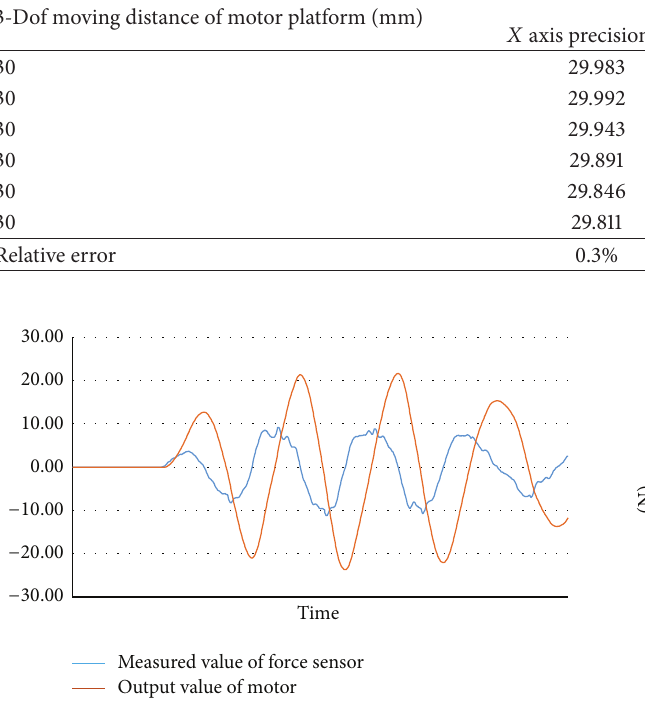
Figure 10: High-speed reverse.